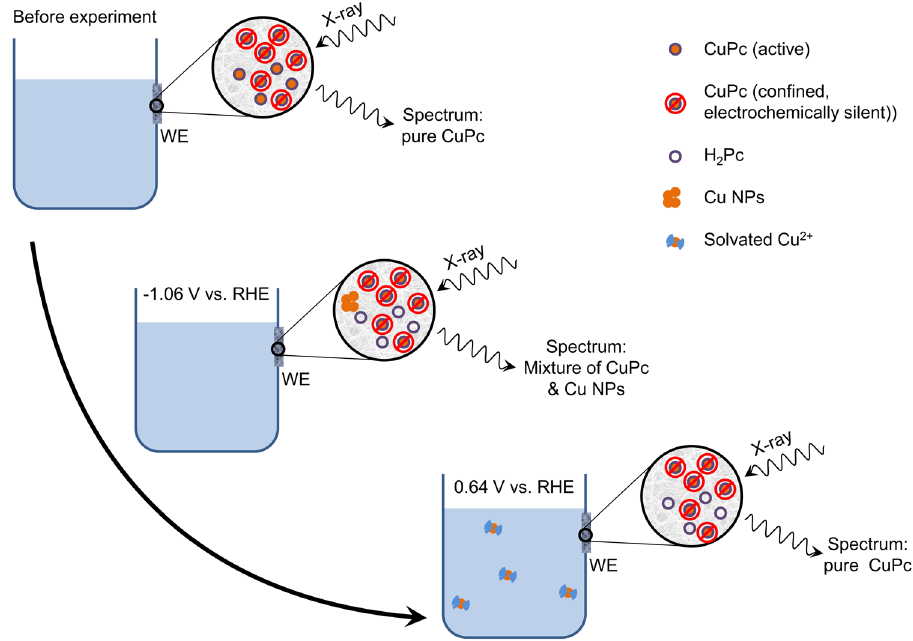
Fig. 1 Schematic summary of the alternative interpretation for experimental reported data 2 . In this scenario, the demetallation of CuPc is an irreversible process. Likewise, because XAS analysis only probes the Cu element inside the fi lm at the electrode, the normalized spectrum of pure CuPc is recovered after the potential is returned to anodic value, while the Cu atoms constituting the CuNPs have leached from the